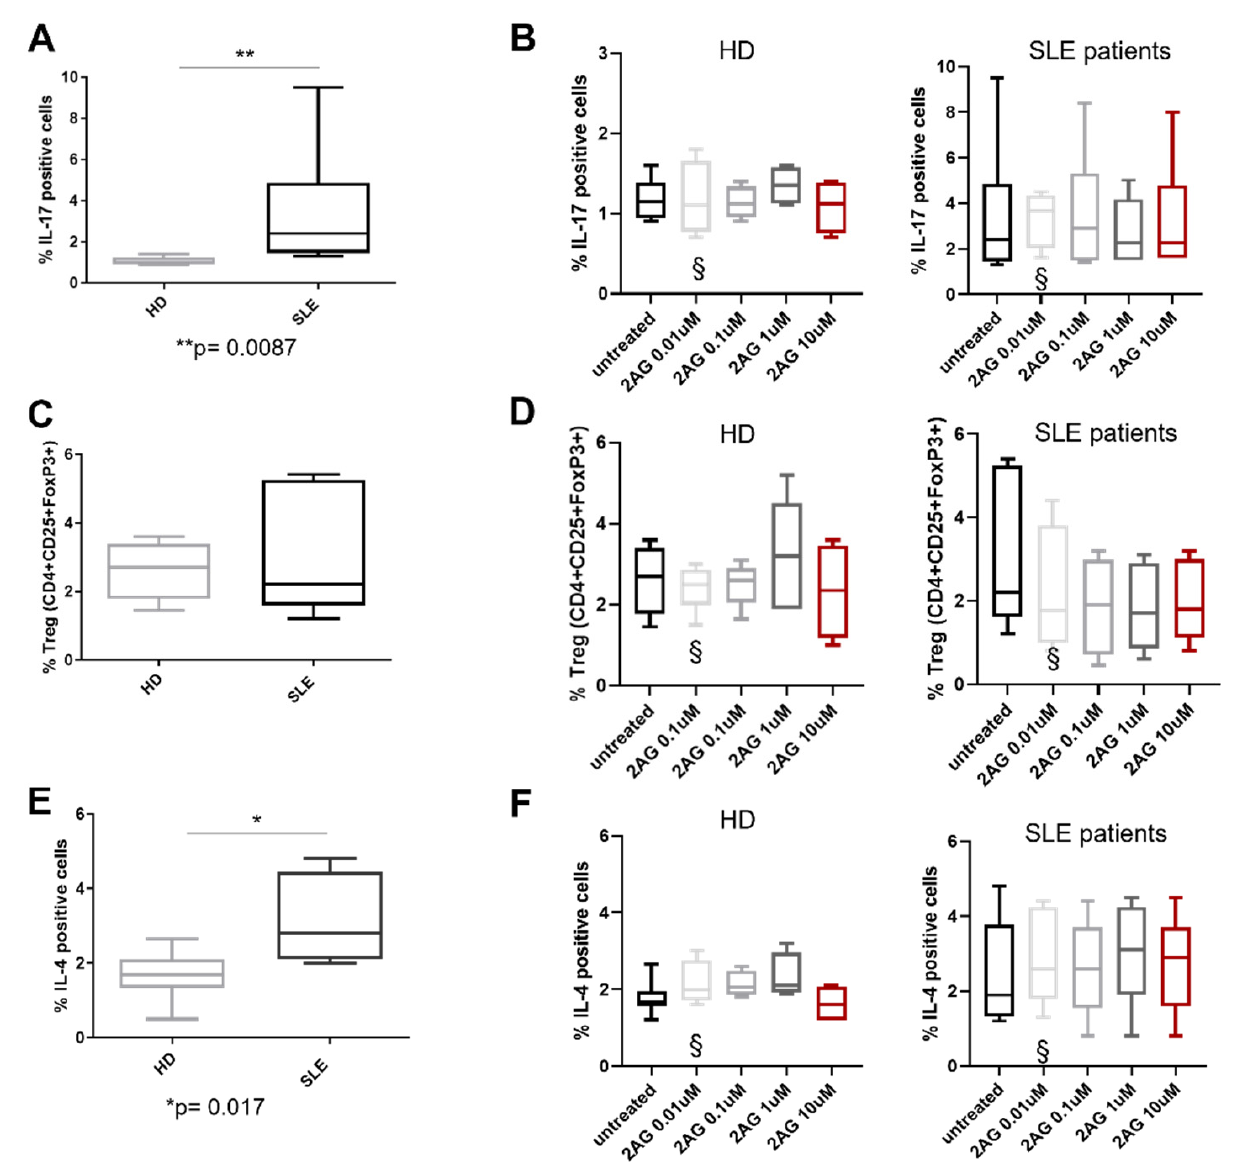
Figure 2. Effect of 2-Arachidonoylglycerol (2-AG) on Th17, Treg, and Th2 lymphocytes. ( A , C , E ) Percentage of Th17, Treg, and Th2 lymphocytes in HD and SLE patients analyzed by flow cytometry (n = 12 for each group). p < 0.05. ( B , D , F ) Percentage of Treg/Th17 cells and lymphocytes expressing IL-4 after treatment with 2-AG at concentrations of 0.01, 0.1, 1 and 10 µ M in HD and SLE patients. § = data obtained from 5 HD and SLE patients representative of entire population.